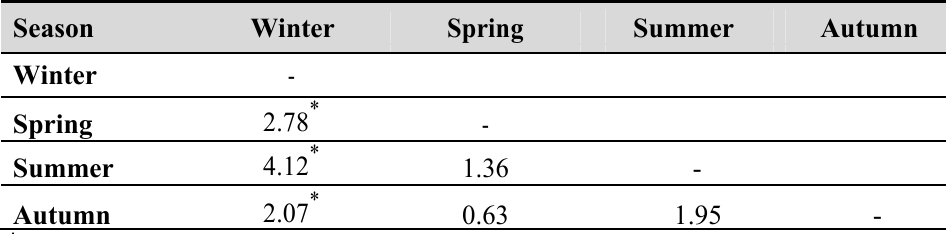
Table 1. Comparative analysis of the mean seasonal visits of schizophrenic patients in the